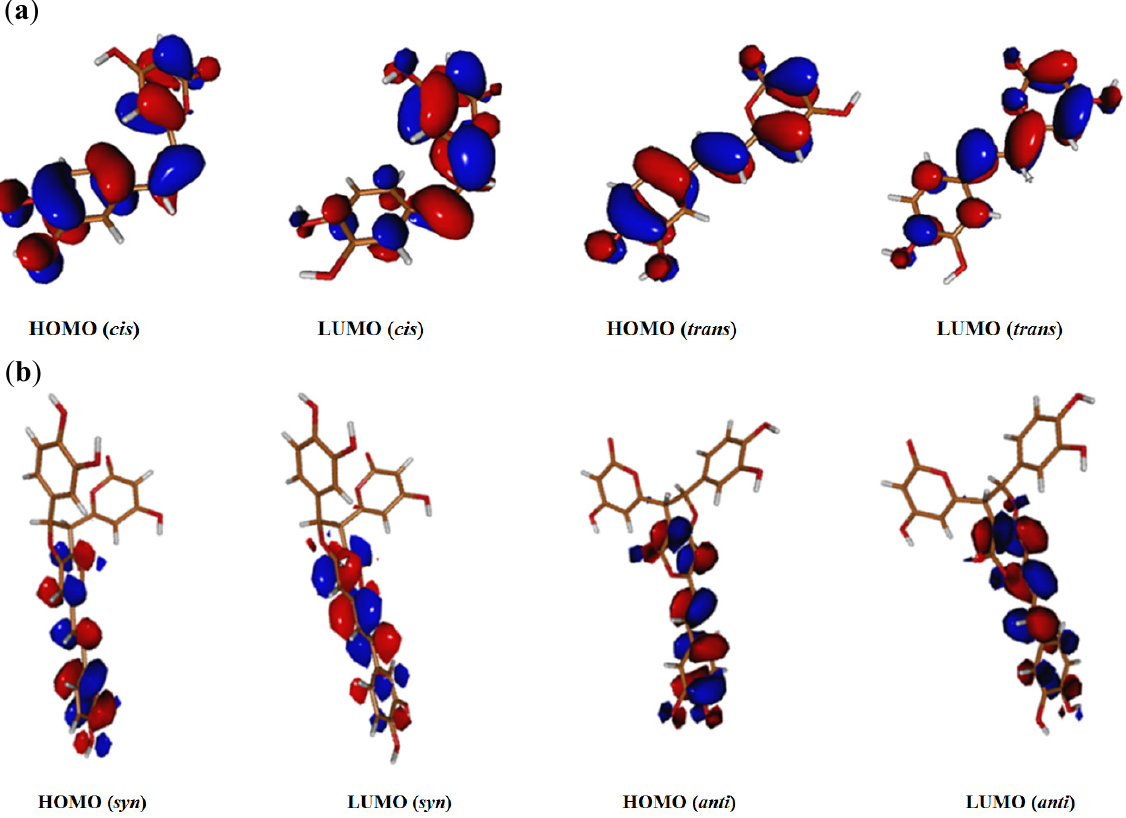
Figure 4. HOMO and LUMO distributions for styrylpyrones ( a ) cis and trans hispidin ( 2 ) isomers; ( b ) syn and anti hypholomine B ( 5 )